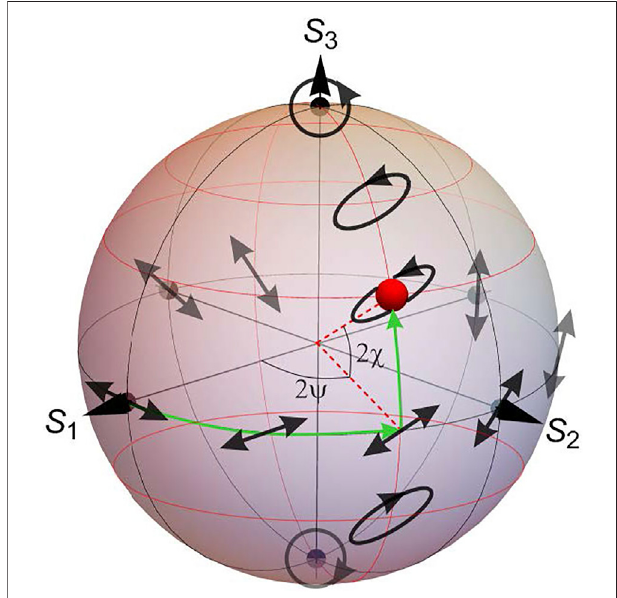
FIGURE 1 | Poincaré sphere and its